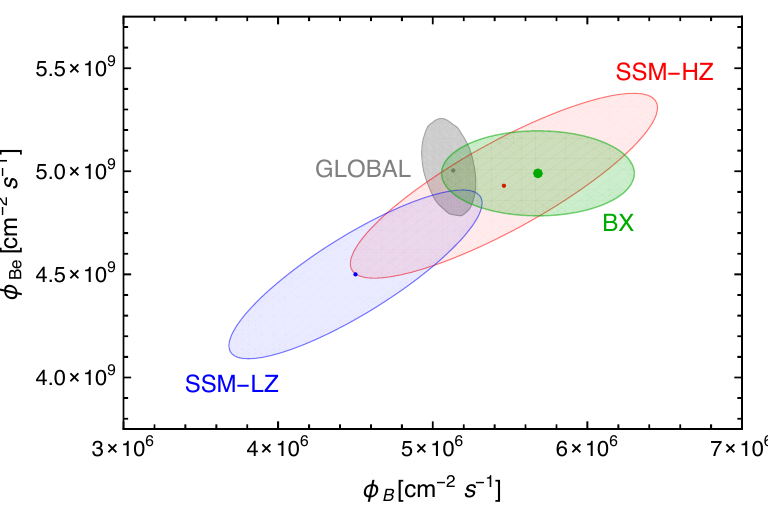
Figure 7. Borexino results for 7 Be and 8 B neutrino fluxes (green dot and area) compared to HZ-SSM (red area) and LZ-SSM (blue area) predictions. The allowed contours shown in gray are obtained by combining the Borexino results with all solar and KamLAND data in a global analysis leaving free the oscillation parameters θ 12 and ∆ m 2 . All contours represent 68.27% C.L. From 12